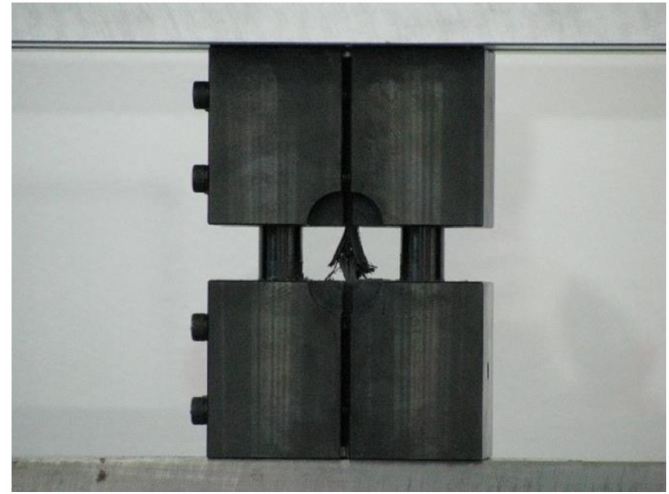
Figure 3. Compression test of the manufactured